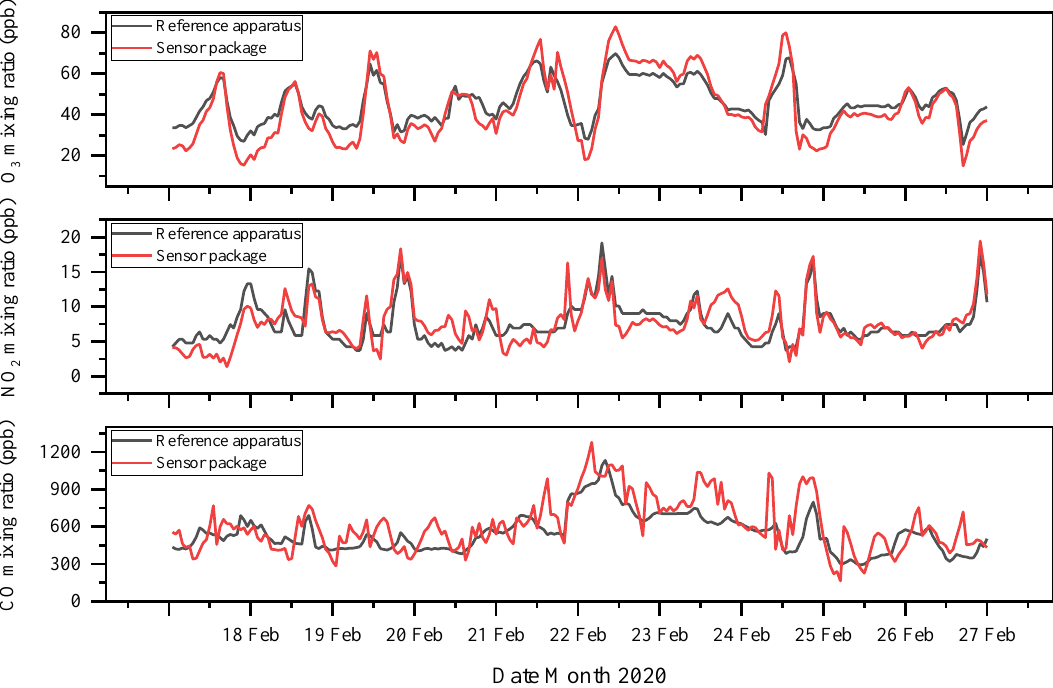
Figure 4. Comparison of temporal variations of the concentrations of O 3 , NO 2 and CO detected by the sensor package and the reference apparatus from 18 to 27 February 2020. The data depicted by the red line come from the sensor package, and the data depicted by the black line come from the reference apparatus.